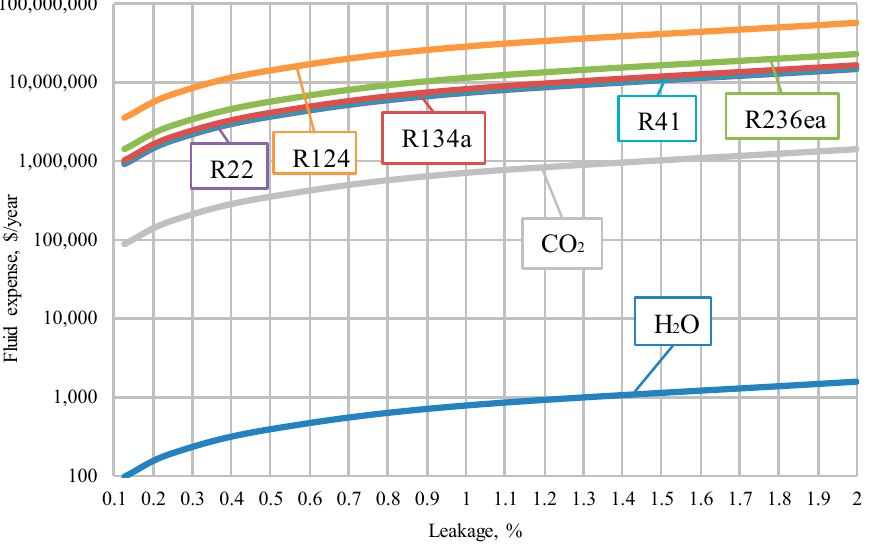
Figure 17. Maximum efficiencies for cycles with regenerator at different initial temperatures. The calculations above were carried out for various initial cycle temperatures.